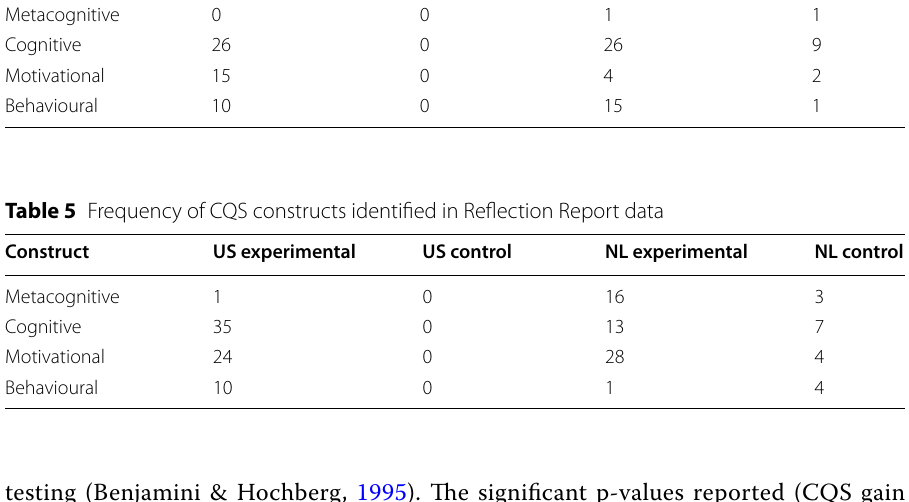
Table 4 Frequency of CQS constructs identified in Focus Group data Construct